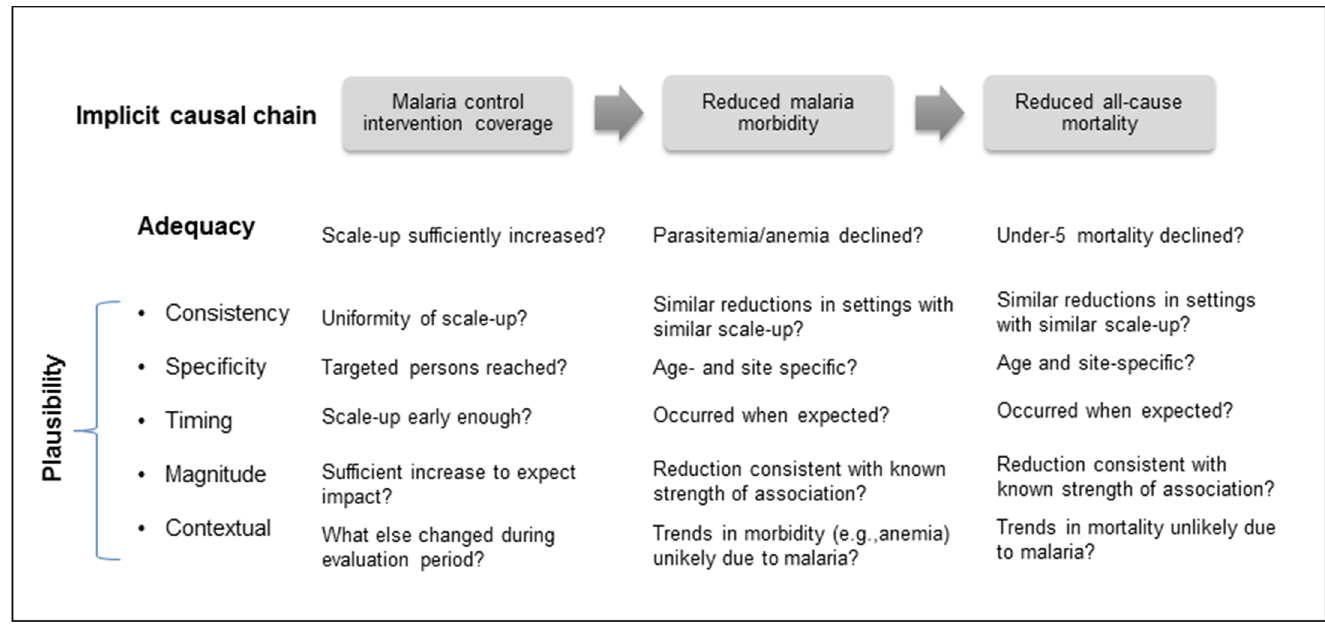
Fig 2. Conceptual framework for constructing an adequacy and plausibility assessment to support the Mainland Tanzania malaria impact evaluation.